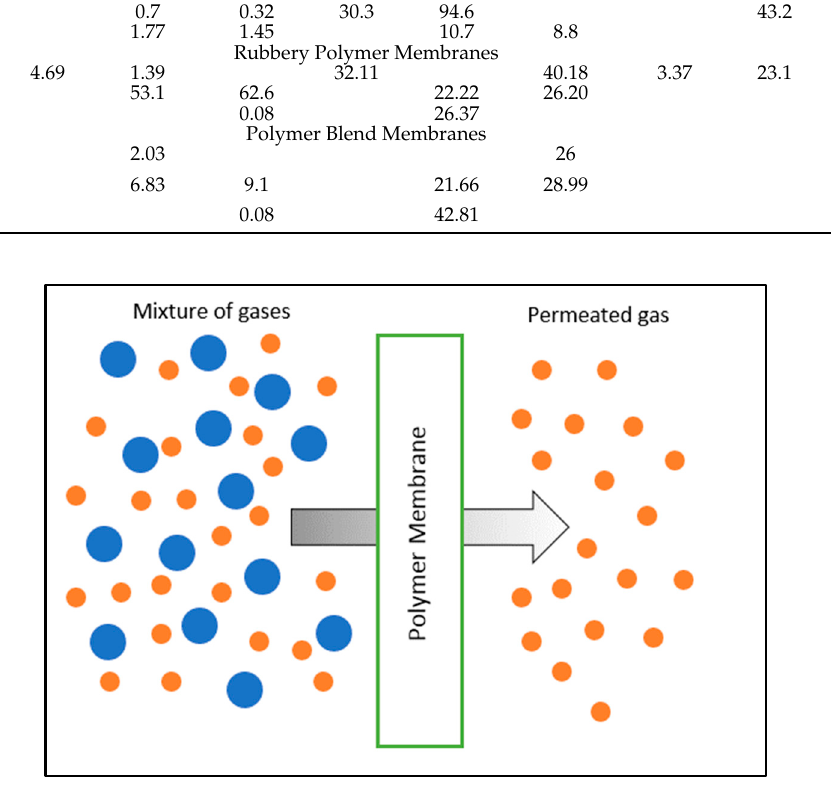
Figure 2. Permeation of gases across polymeric membrane. Reprinted/adaptedwith permission from Khaki et al. [42] (2021) Elsevier Copyright. Table 3. Permeability and Selectivity of Polymer Membranes .